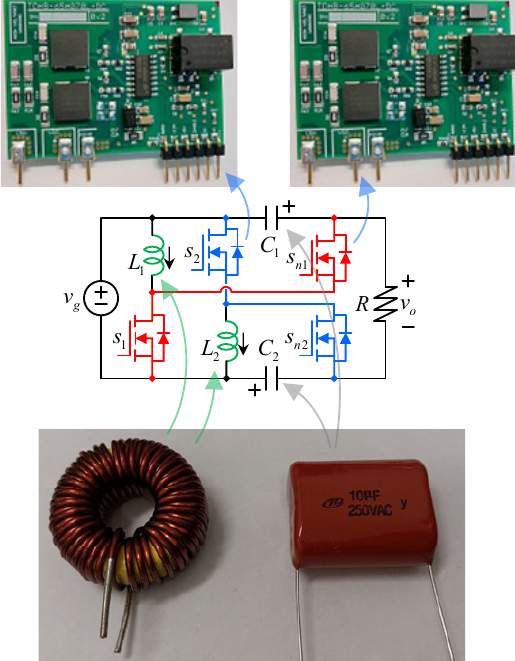
Figure 15. Experimental prototype diagram and main part photos.